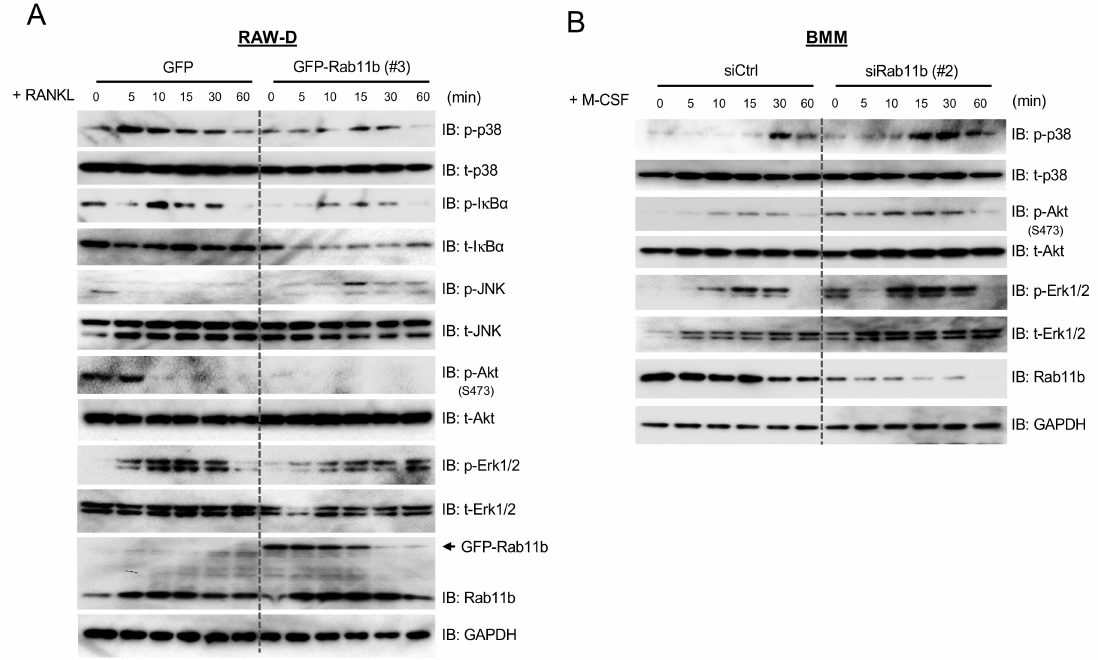
Figure 4. The e ff ects of Rab11b on NFATc-1 upstream signaling cascades in macrophages stimulated by RANKL and M-CSF, respectively. ( A ) RAW-D cells expressing GFP or GFP-Rab11b (clone #3) were incubated with serum ( − / − ) culture media in the absence of RANKL. After RANKL (300 ng / mL) supplementation, the cells were incubated for the indicated times, and subsequently collected. The cell lysates were subjected to SDS-PAGE followed by immunoblotting for the detection of total expression levels of p-p38, t-p38, p-I κ B α , t-I κ B α , p-JNK, t-JNK, p-Akt (S473), t-Akt, p-Erk 1 / 2, t-Erk 1 / 2, Rab11b, and GAPDH was used as a loading control. The shown data were obtained from two independent repeats. ( B ) BMMs transfected with non-targeting siRNA (siCtrl) or Rab11b siRNA (siRab11b, type 2) were pre-incubated with serum ( − / − ) culture media in the absence of M-CSF. Then, the cells were incubated with M-CSF (50 ng / mL) for the indicated periods, and subsequently harvested. The cell lysates were subjected to SDS-PAGE followed by immunoblotting for the detection of p-p38, t-p38, p-Akt (S473), t-Akt, p-Erk 1 / 2, t-Erk 1 / 2, Rab11b, and GAPDH was used as a loading